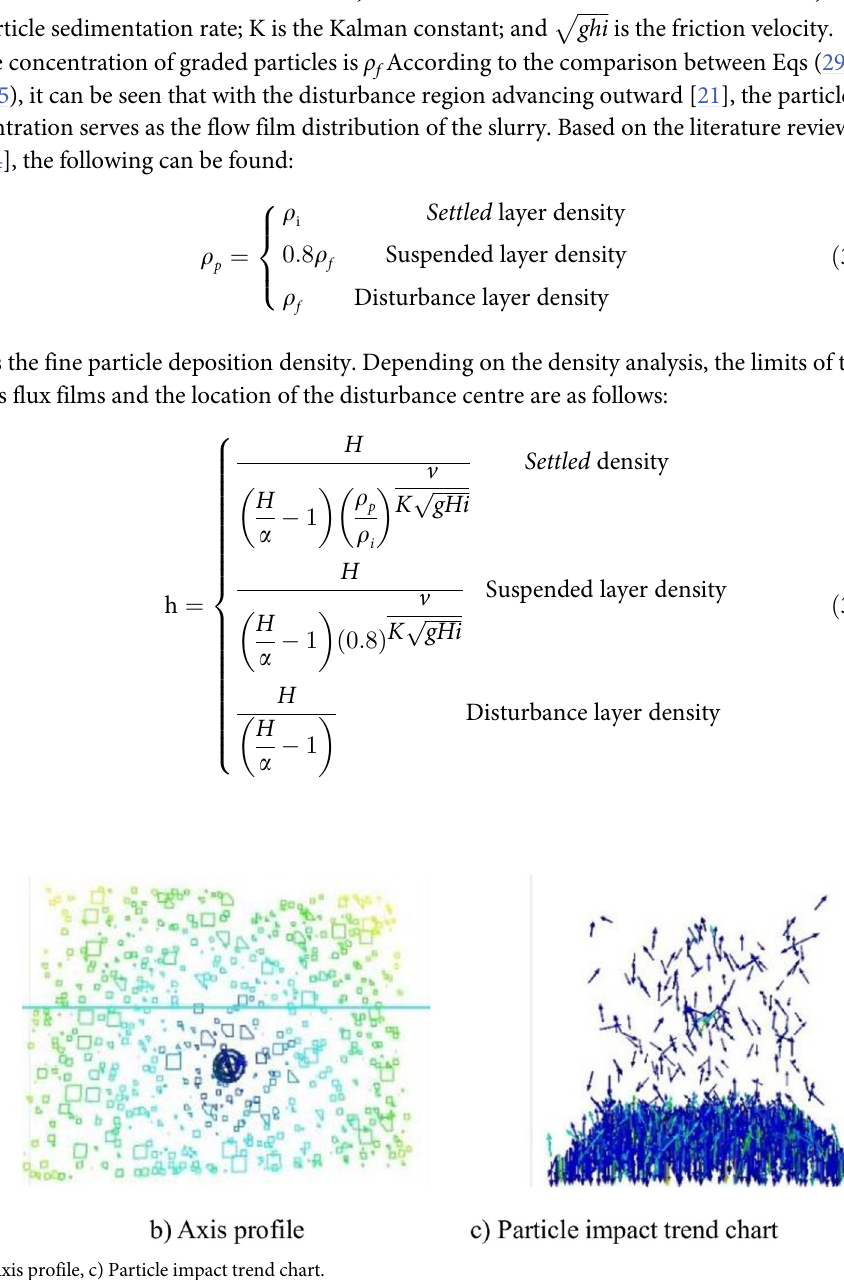
PLOS ONE | https://doi.org/10.1371/journal.pone.0281708 March 9,